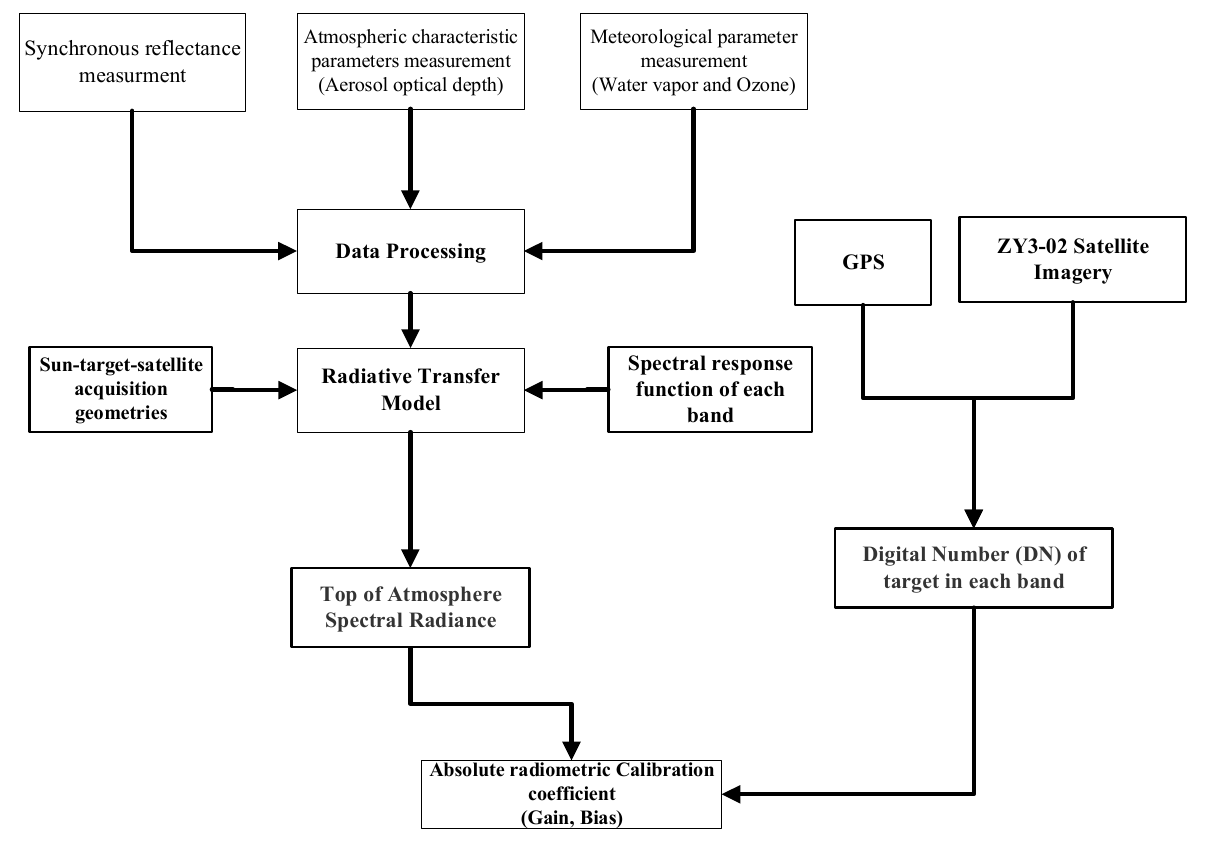
Figure 5. Flow chart of the reflectance-based radiometric calibration approach.